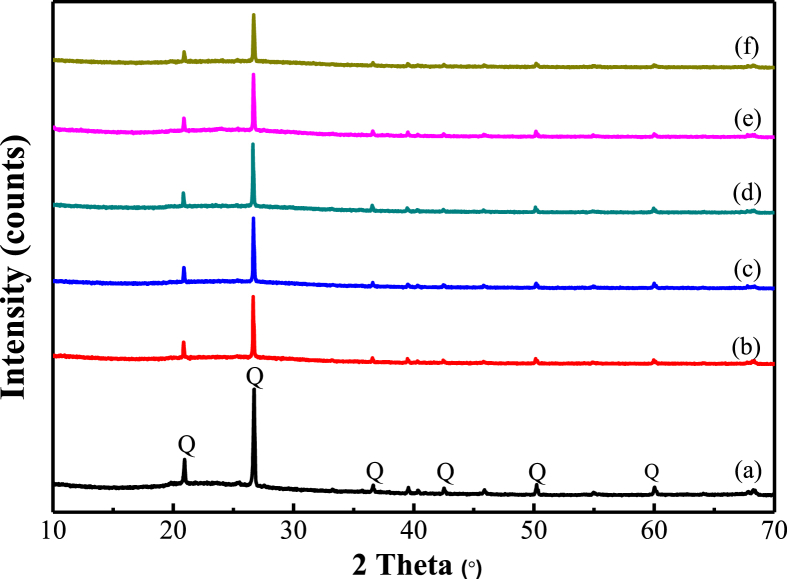
XRD patterns of metakaolin and geopolymers with different H3PO4/Al2O3 ratios. Q, Quartz (PDF # 79-1906). (a) Metakaolin; (b) H3PO4/Al2O3 = 1.0:1; (c) H3PO4/Al2O3 = 1.1:1; (d)H3PO4/Al2O3 = 1.2:1; (e) H3PO4/Al2O3 = 1.3:1; (f) H3PO4/Al2O3 = 1.4:1.